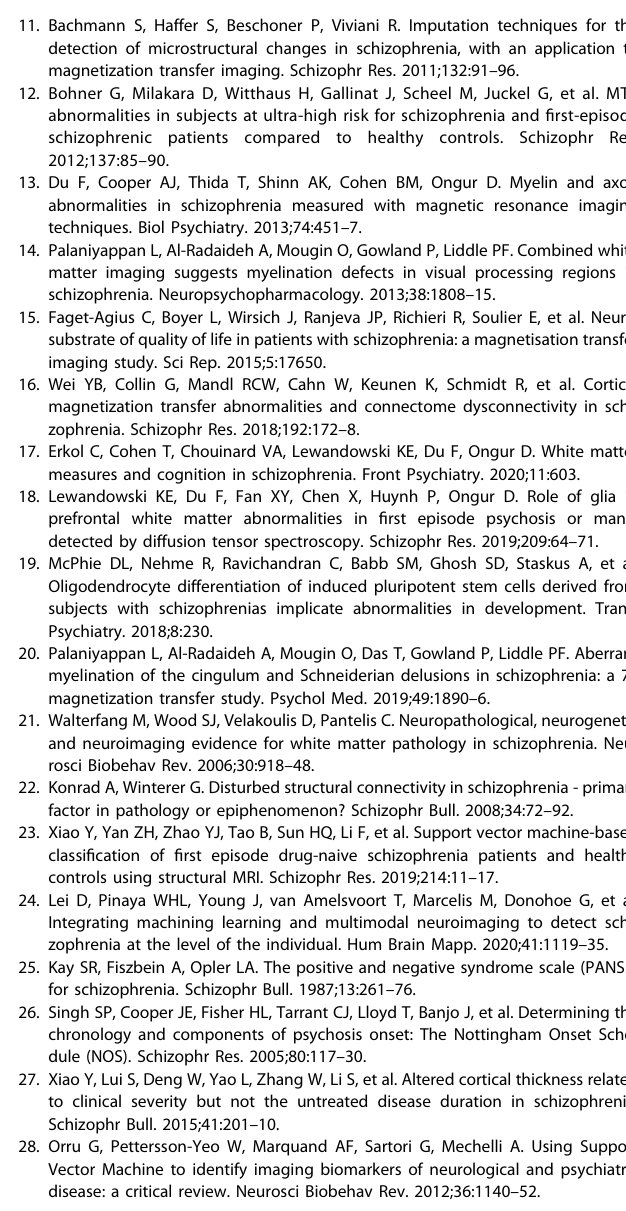
Fig. 3 Classi fi cation performance based on whole-brain MTR maps. A The confusion matrix of classi fi cation between FES and HC. B Receiver operating characteristic curve for a prediction model based on whole-brain MTR maps using support vector machine. MTR magnetization transfer ratio, FES fi rst-episode schizophrenia, HC healthy controls, AUC area under receiver operating characteristic